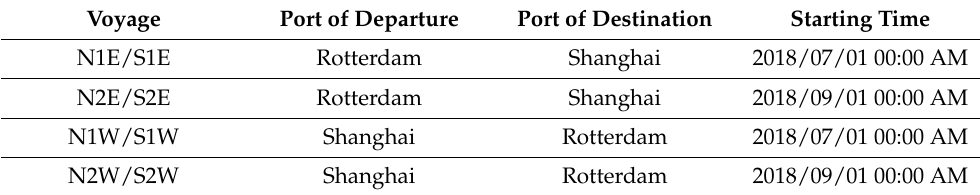
Table 3. Case study